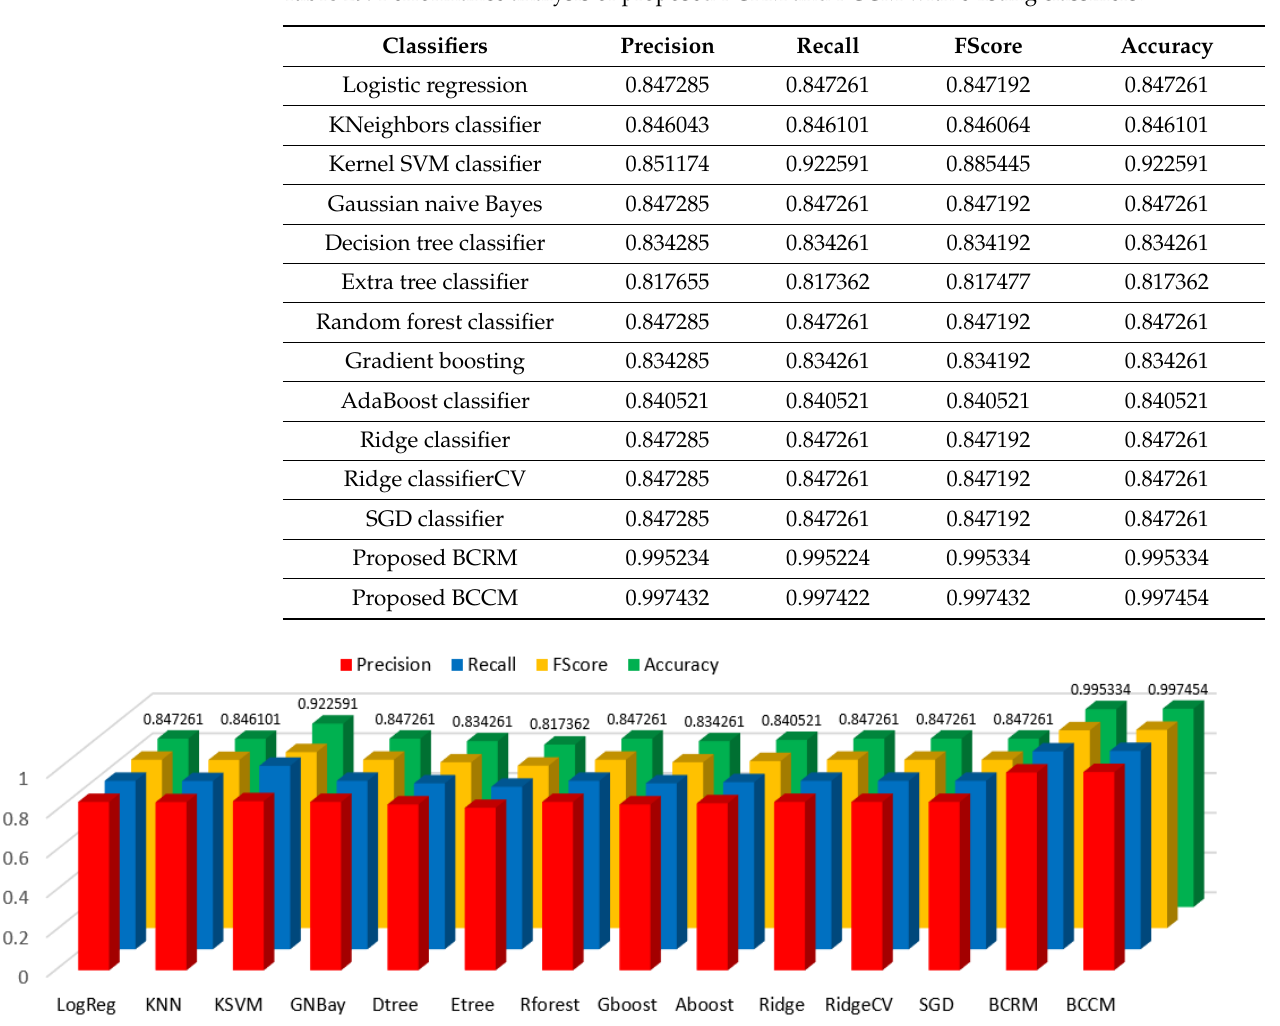
Table 29. Performance analysis of proposed BCRM and BCCM with existing classifiers.